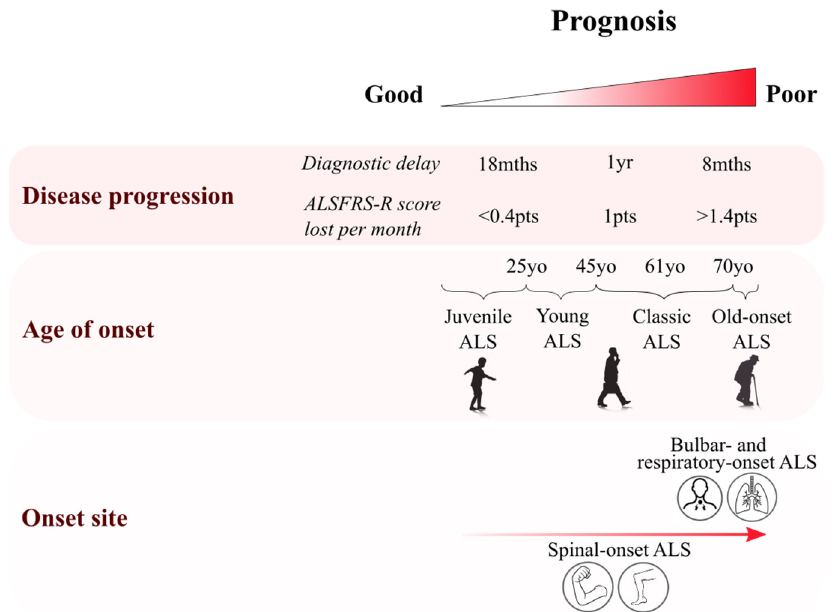
Figure 1. Clinical features of amyotrophic lateral sclerosis (ALS) and their role in prognosis. Diagram summarising the heterogeneity of clinical features in ALS. Multiple features have been associated with a poor prognosis, with an elderly onset being associated with a rapid progression of symptoms and a poor prognosis, especially among elderly females presenting with bulbar-onset phenotype [12]. Disease progression can be assessed either by diagnostic delay or by the ALS functional rating score (ALSFRS: amyotrophic lateral sclerosis functional rating scale). Poor prognosis is associated with patients whose ALS diagnosis has been given less than 8 months after symptom onset, or among those patients losing more than 1.4 points / month on the ALSFRS scale [13].